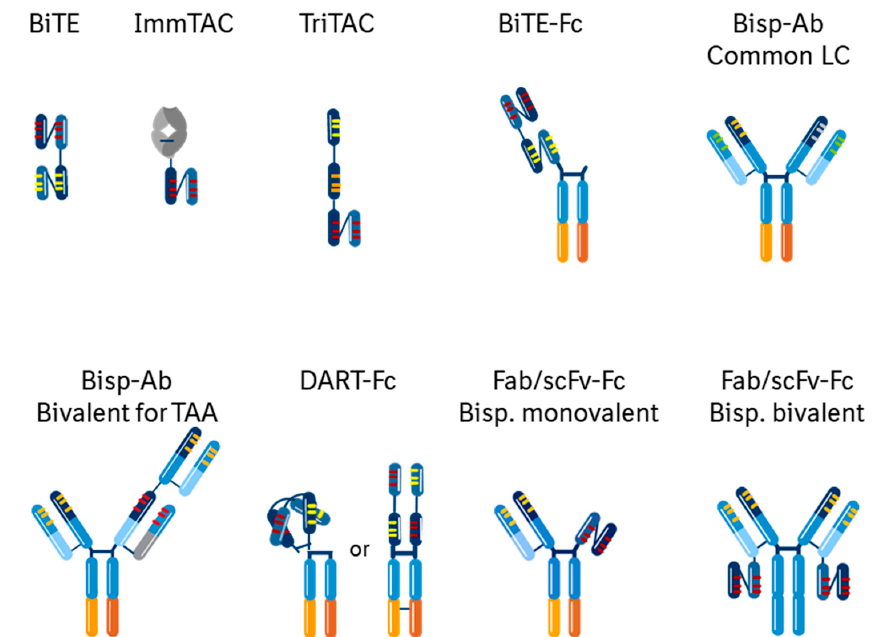
Figure 2. Examples of some of the Bispecific structures of T-cell Engager molecules in clinical trials. CDRs in the variable light and variable heavy chains for the same target are in the same color. Knob-in-Hole and other CH3 engineering technologies in the CH3 domain of the Fc are indicated by the different shade of orange.